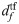
Experiment 3: Feedback depending on time since last cue.(A) Schematic of the experiment. Input consists of four streams: one cue channel u+, a stream of bounded, uniformly distributed noise uarb that is filtered by a Gaussian kernel, and the additional fast dftf and slow dstf trained feedback signals that are ramps of duration 600 and 300 Reservoir time steps, respectively. In addition to the trained feedback signals, the fDCR computes three desired outputs d1, d2, and d3, corresponding to the sum of the feedback signals, their difference, and nonlinear function of the fast ramp and the random input, respectively. (B) Comparison between desired (blue) and observed (orange) fDCR output signal d3. (C) Scatter plots of the target verses observed output for both training (yellow) and validation (brown) data sets, when the target is d3. (D) Correlation coefficient between desired and observed fDCR output for both training (brown) and validation (yellow), when the target is d3.